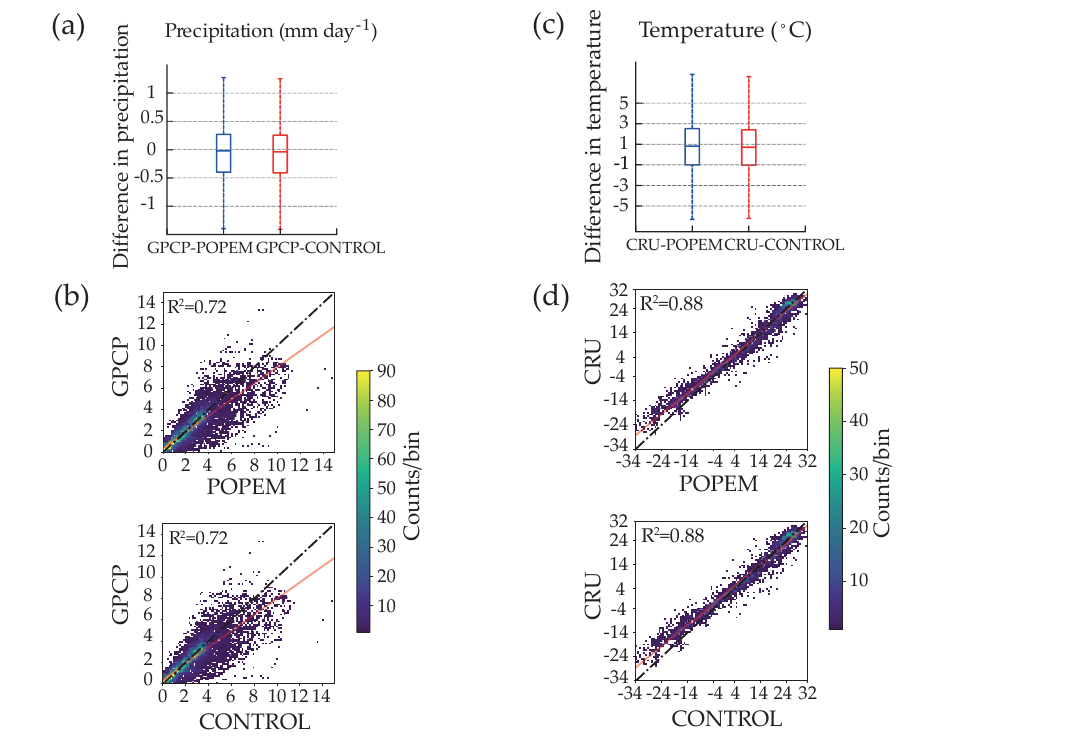
Figure 4. Box plots of CESM simulation bias for precipitation (a) and temperature (c) . (b) Scatter plots comparing the annual mean precip- itation (1980–2000) at every grid point for GPCP and CESM simulations (POPEM and CONTROL). (d) Scatter plots comparing the annual mean temperature at every grid point for CRU and CESM simulations (POPEM and CONTROL). Units are in mmday − 1 (precipitation) and in ◦ C